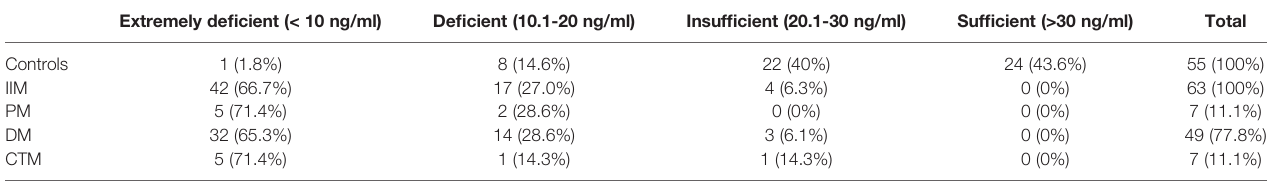
TABLE 2 | Number (%) of IIM patients and controls with extremely de fi cient, de fi cient, insuf fi cient and Suf fi cient serum levels of